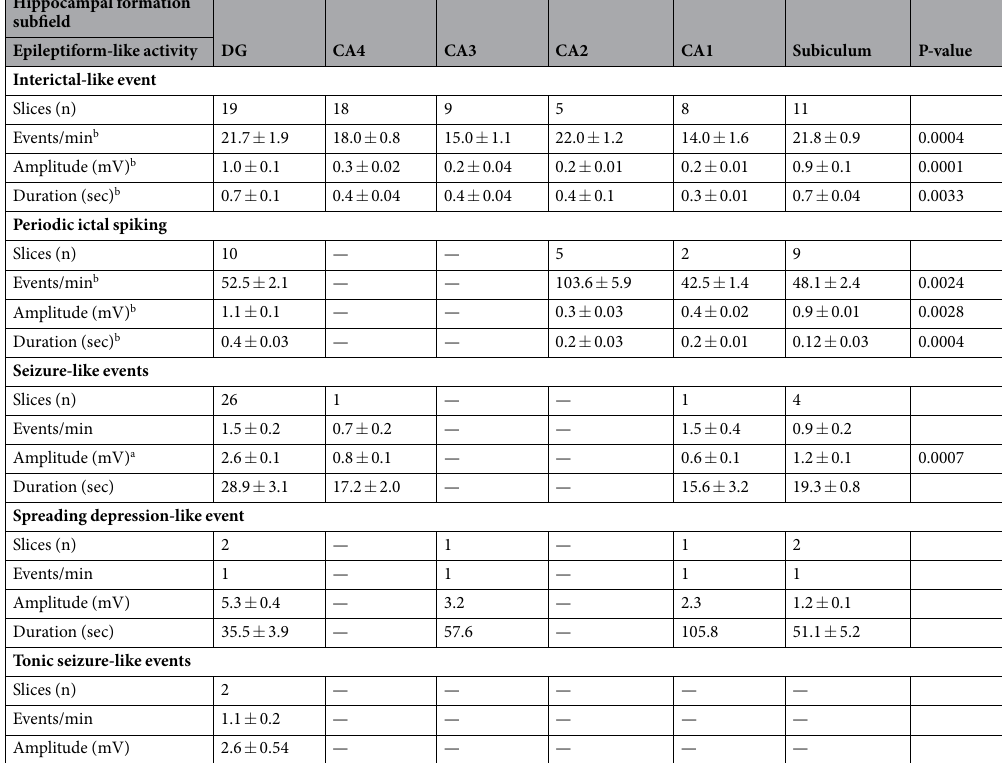
— — — — — — Table 1. Parameter values of the different patterns of epileptiform activity in hippocampal formation subfields. a P-values are indicated where significant difference for group were observed using Mann-Whitney-Wilcoxon U test. b P-values are indicated where significant difference for group were observed using Kruskal-Wallis H test. All data are expressed as mean ±